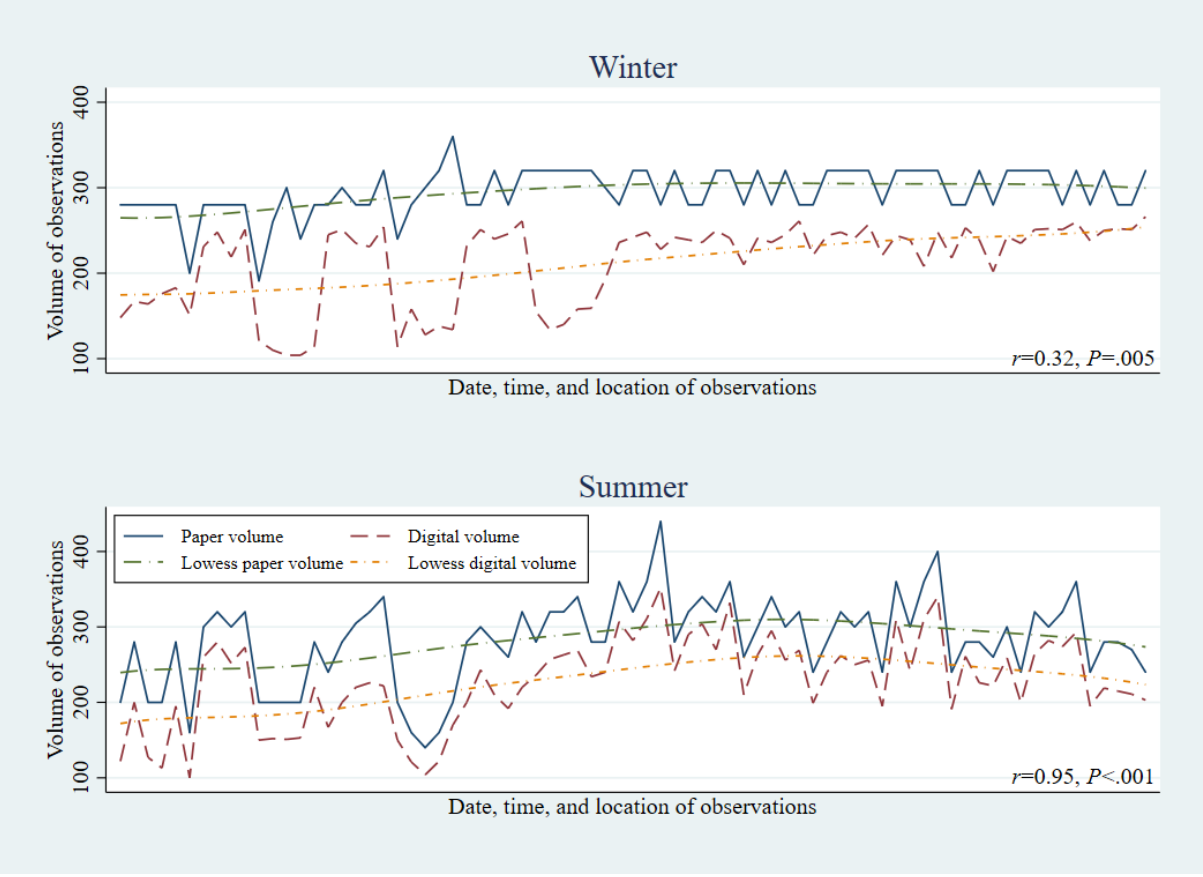
Figure 2. Seatbelt use: correlation between digital and paper volumes of observations by